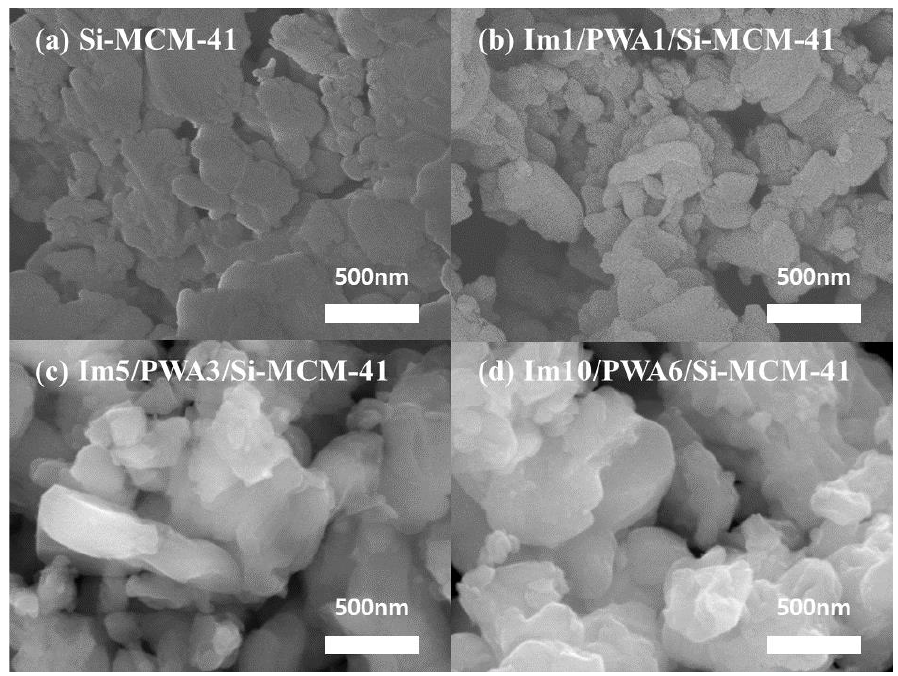
Figure 3. FE-SEM images for ( a ) Si-MCM-41, ( b ) Im1/PWA1/Si-MCM-41, ( c ) Im5/PWA3/Si-MCM- 41, and ( d ) Im10/PWA6/Si-MCM-41.